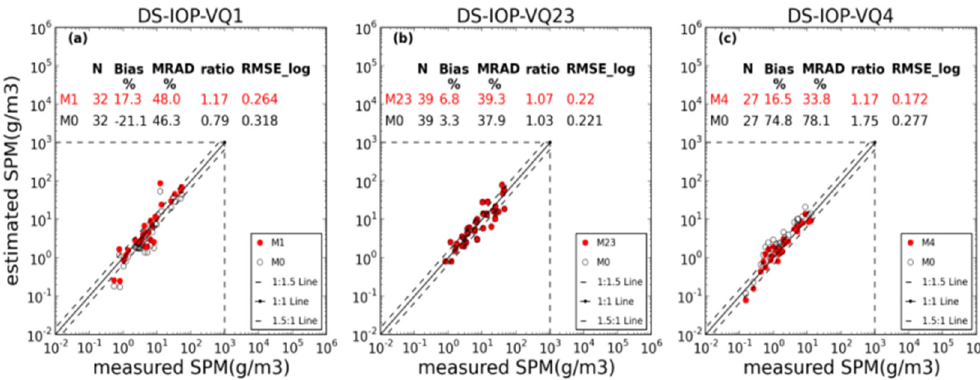
Figure 11. Comparison of the measured and inversed SPM by SAA model for the data points of the Q1 , Q23 , and Q4 quartiles. In each panel, black circles represent the SPM values estimated using the averaged C ρ value over DS-IOP-D , and red circles represent those estimated from the averaged C ρ value over each quartile-averaged. The values of the statistical indicators are provided for each quartile. Solid line represent 1:1 line and dashed lines represent 1.5:1, 1:1.5 lines. ( a ) DS-IOP-VQ1; ( b ) DS-IOP-VQ23; ( c ) DS-IOP-VQ4.